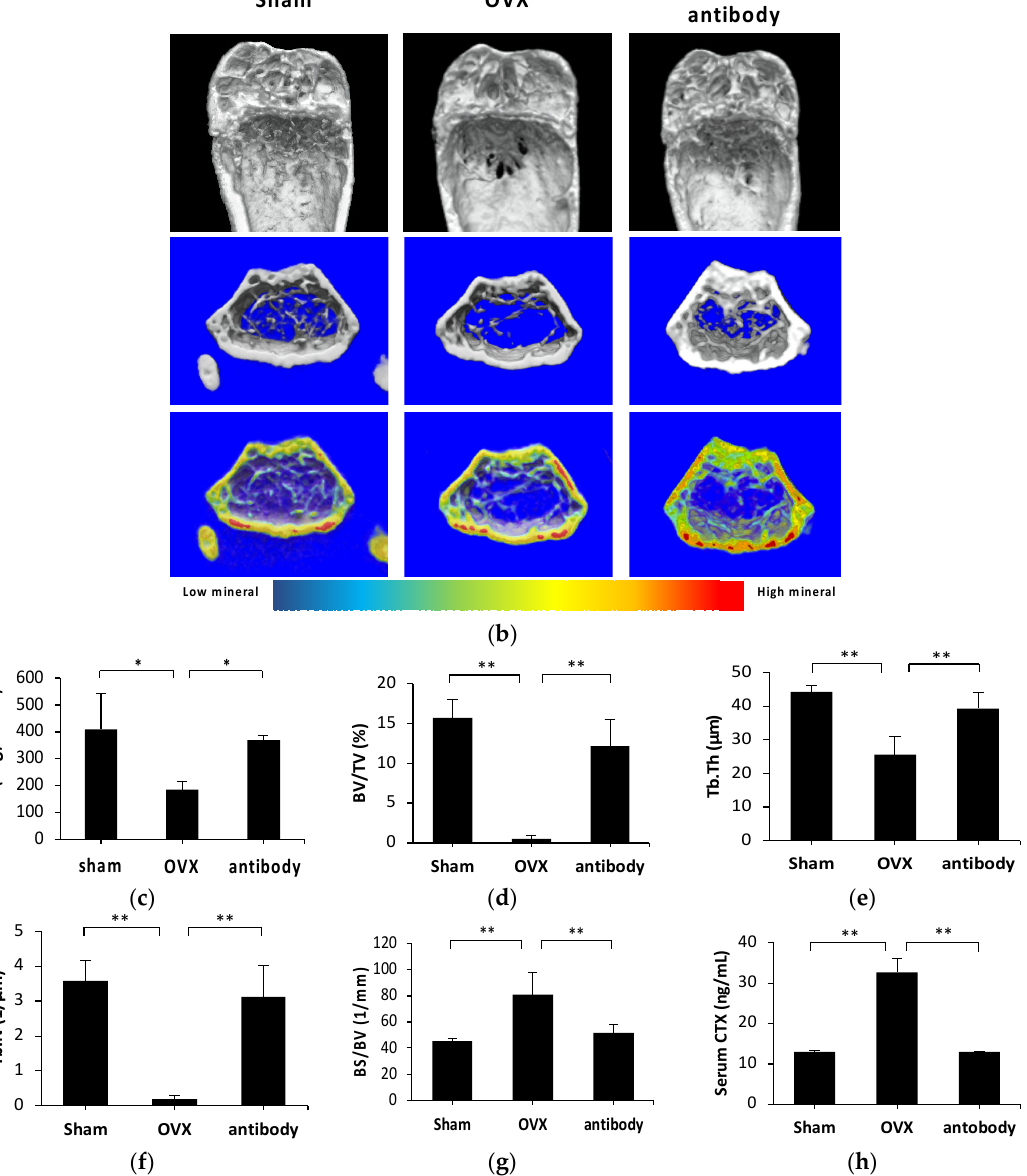
Figure 3. Anti-c-fms antibody inhibited bone resorption and bone loss in ovariectomized (OVX) mice. ( a ) Body weight changes in OVX mice treated with anti-c-fms antibody. OVX mice were treated with 500 μ g/week/mouse anti-c-fms antibody (injection on day 4, day 11, day 18 and day 25 after operation). The date of injection of the antibody is indicated by the arrow. ( b ) Representative micro-CT images of trabecular bone microarchitecture in femurs. Thirty days from the start of the experiment, femurs from OVX mice, OVX mice treated with anti-c-fms antibody and sham mice were assessed by micro-CT. Phantoms with known BMD were imaged under the same conditions as the bones, and BMD images of cortical and trabecular bone were created from the CT images using the BMD values as pixel values in the third set of pictures. The height of the BMD is shown in color scale. Quantitative measurements of femur trabecular bone-related morphometric parameters, including ( c ) BMD, ( d ) BV/TV, ( e ) Tb.Th, ( f ) Tb.N and ( g ) BS/BV ( n = 4). ( h ) Serum levels of CTX were assessed using a CTX Assay kit. Data are expressed as the mean ± standard deviation (SD). Statistical significance of differences between groups was determined using Scheffe’s test ( n = 4; ** p < 0.01 * p < 0.05).